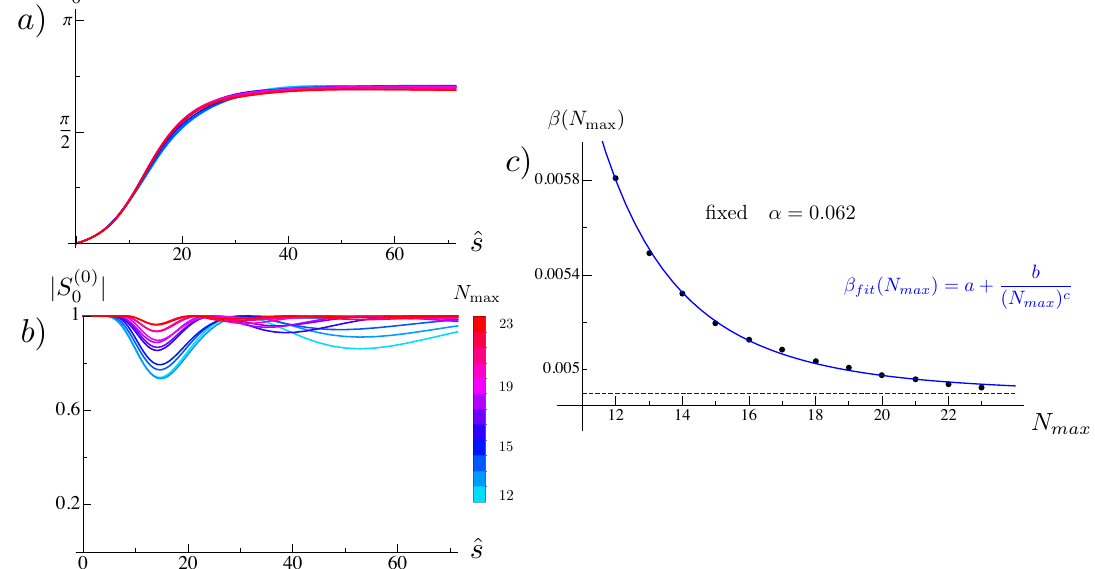
= Re ( 1 log S (0) ) at a given point at the boundary 0 0 2 i as we increase π